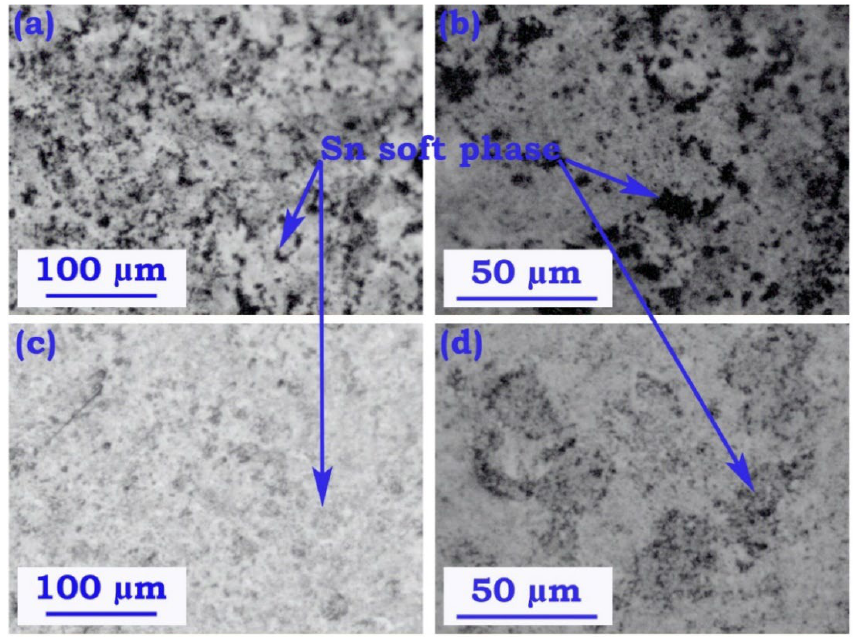
Figure 7. Optical micrograph of ( a , b ) IQC-10Sn hot-pressed at 650 ℃ (1073 K) for 15 min (IQC-10Sn- HP); ( c , d ) IQC-10Sn hot-pressed (650 °C) and annealed 800 °C for 4 h (IQC-10Sn-HPA).